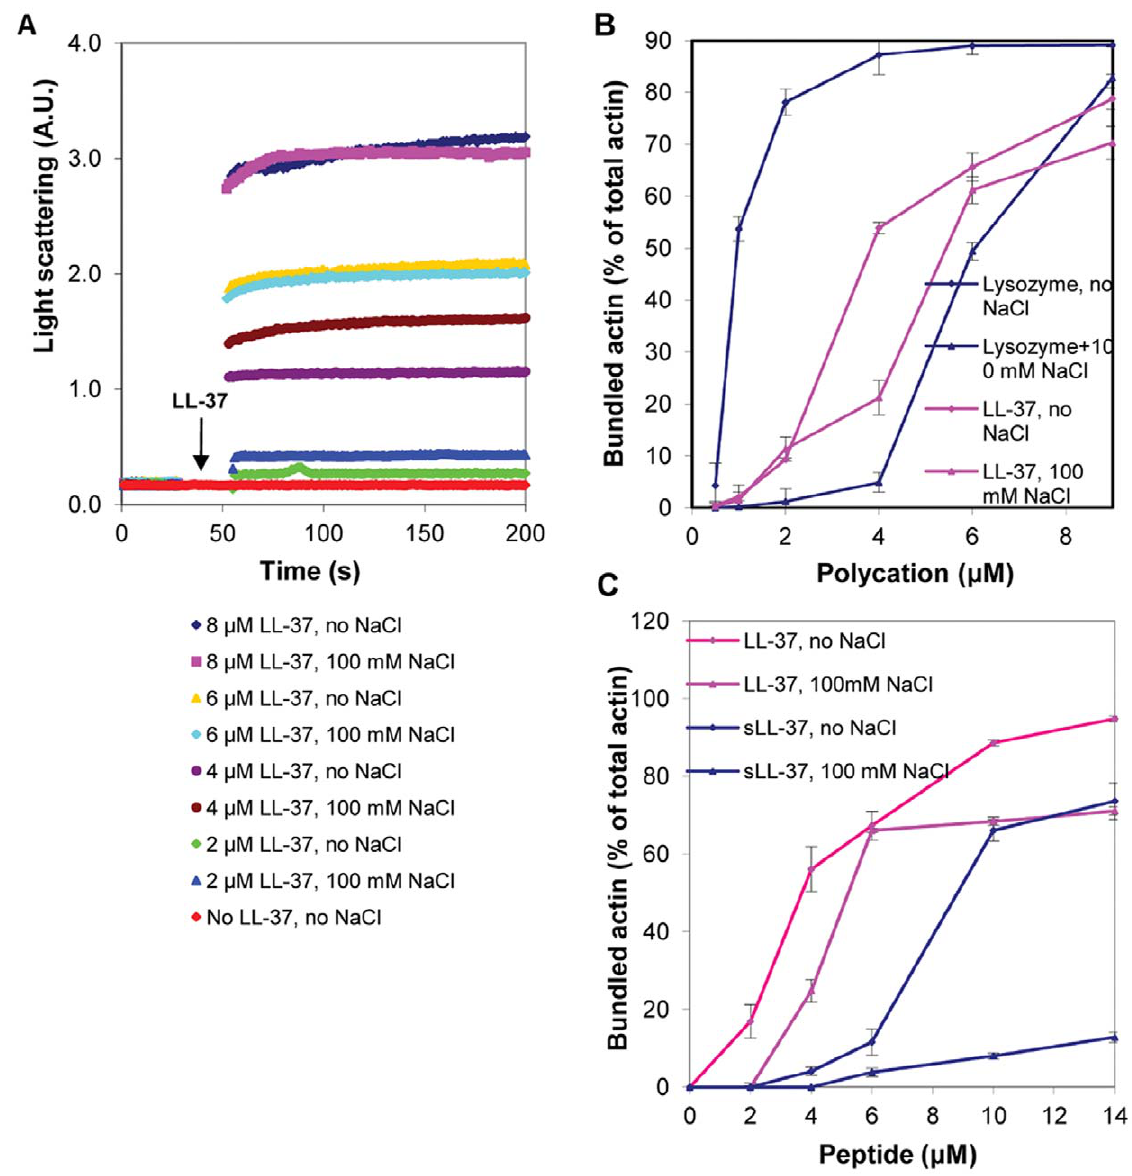
Figure 3. LL-37, scrambled LL-37 and lysozyme induced bundle formation of Mg-F-actin at low and physiological (100 mM NaCl) ionic strength. ( A ) Kinetics of LL-37-induced bundle formation: LL-37 (2–8 m M) was added to MgF-actin (2 m M) and bundle formation was followed as an increase in light scattering at 350 nm. Presented data are representative of three independent experiments. ( B ) Extent of LL-37 and lysozyme induced bundle formation: LL-37 or lysozyme (0.5–9 m M) were added to Mg-F-actin (4 m M). Samples were centrifuged at 20,800 6 g, for 8 min and the supernatants were analyzed by SDS-PAGE and densitometry. ( C ) Extent of LL-37 and scrambled LL-37 induced bundle formation: LL-37 or scrambled LL-37 (2–14 m M) were added to MgF-actin (4 m M) and bundle formation was measured as in (B). The presented data are mean and standard deviation of three independent experiments in (B) and (C). 6 m M DNase1, cofilin, or 200 mM NaCl. Bundling and dissociation was monitored as a change in light scattering.